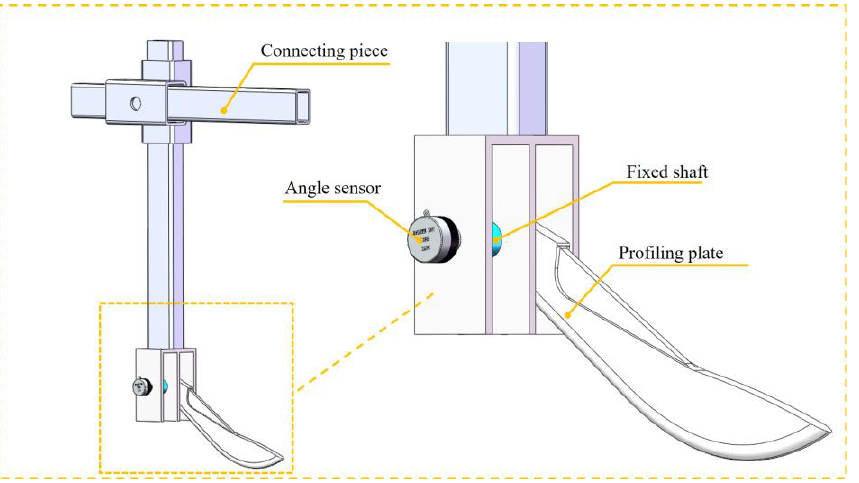
Figure 5. Structure diagram of profiling mechanism.